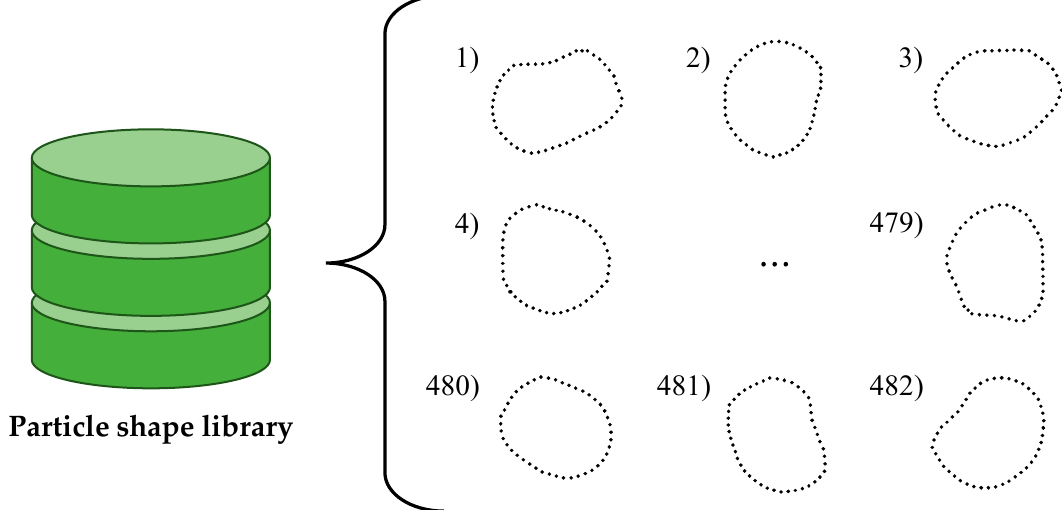
Figure 2. Schematic illustration of the particle-shape library consisting of actual noncircular fibers.